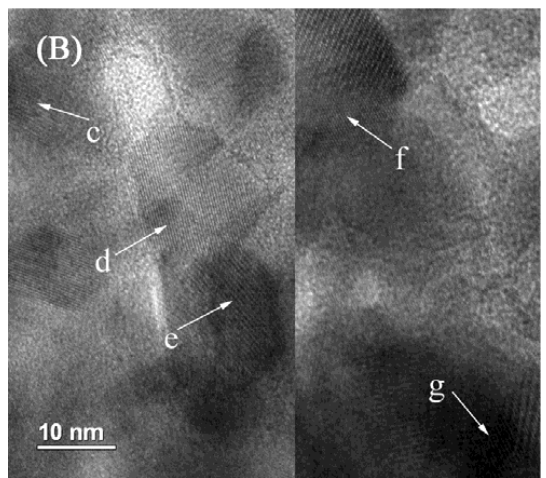
Figure 5. TEM images of the catalysts: ( A ) 10Mn ‐ 5Co/TiO 2 (673 K); and ( B ) 10Mn ‐ 5Co/TiO 2 (773 K). (a. CoMnO 3 (012); b. CoMnO 3 (003); c. CoMn 2 O 4 (111); d. anatase (101); e. MnO 2 (200); f. CoMnO 3 (012); g. CoMnO 3 (101)).